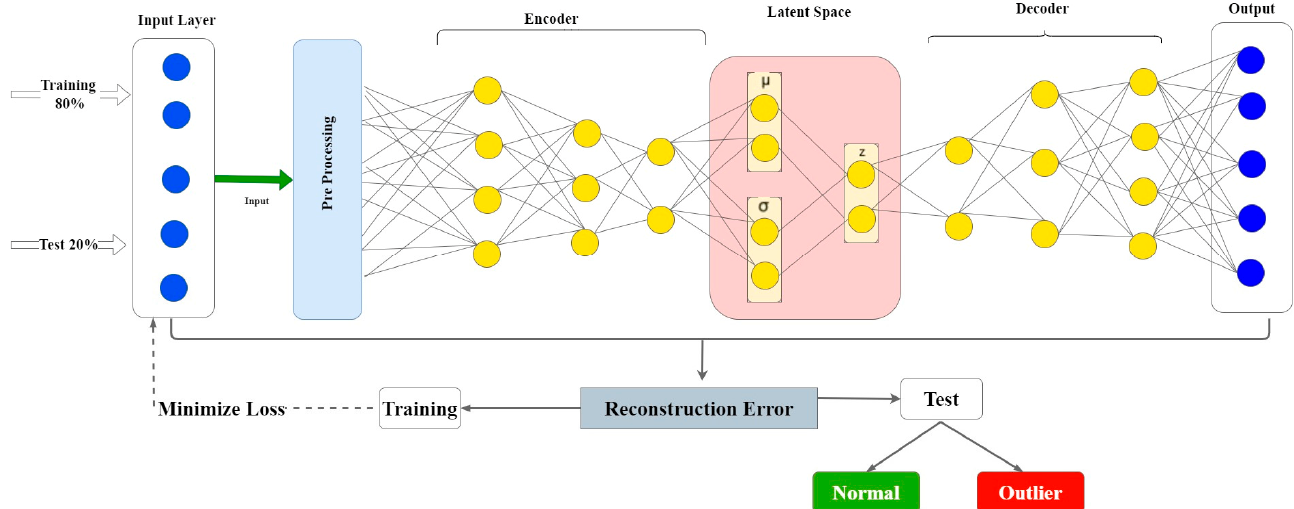
Figure 2. Proposed Variational Auto-Encoder framework for outlier detection.